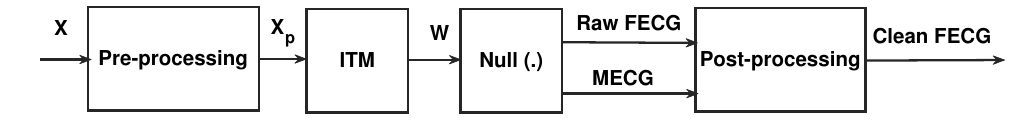
Figure 5. The proposed NSITM